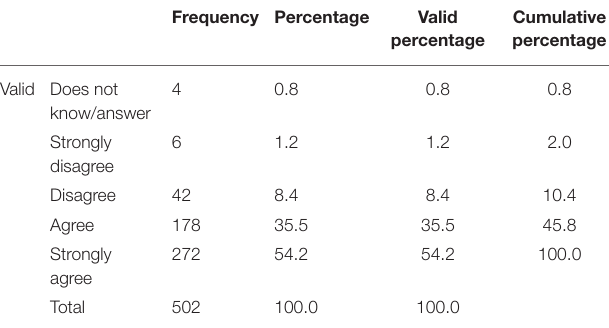
FIGURE 6 | What is stated objectively—what is stated